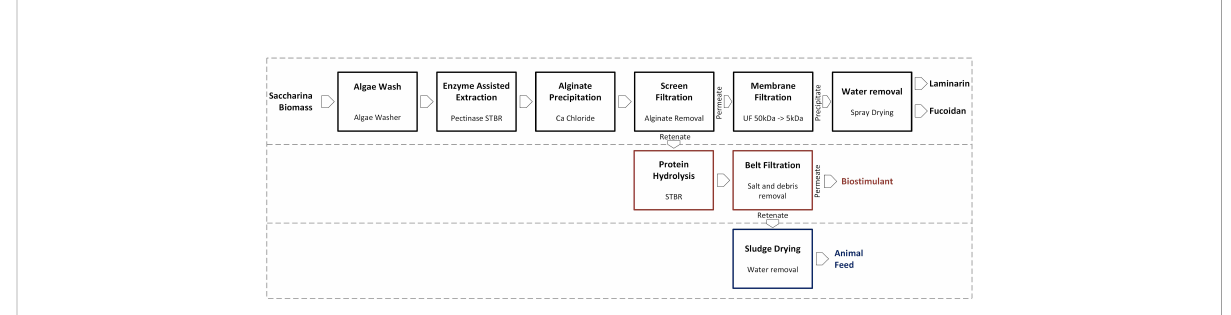
FIGURE 2 Simpli fi ed fl owchart for laminarin and fucoidan production biore fi nery using enzyme assisted